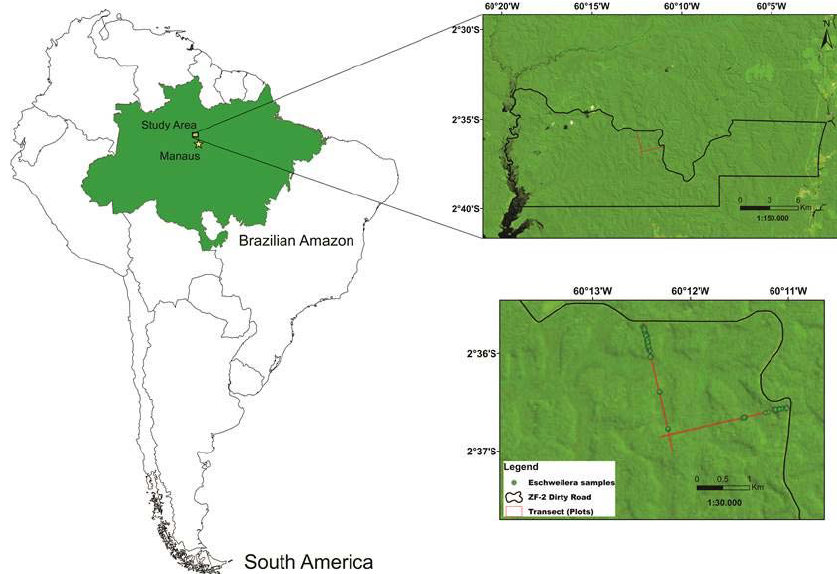
Figure 1. Location map of the Brazilian Amazon, ZF ‐ 2 Tropical Forestry Station in proximity to the city of Manaus and the two transects (east ‐ west (E ‐ W) and north ‐ south (N ‐ S)) in red, where the Eschweilera sample trees were measured.